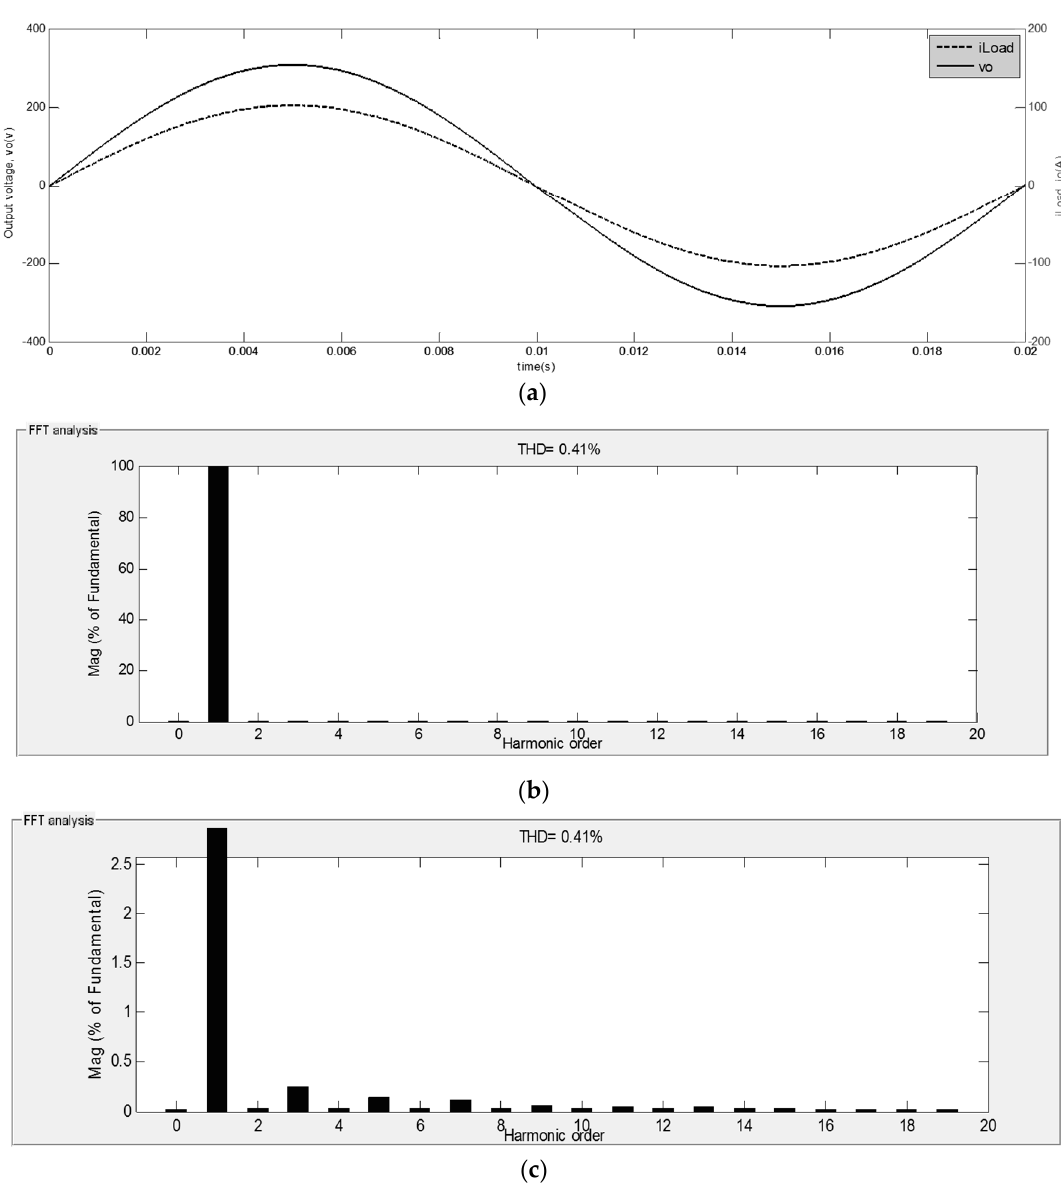
Figure 5. Simulation results for a resistive load: ( a ) output voltage and load current waveforms for a resistive load; ( b ) the spectrum of the output voltage for a resistive load; and ( c ) the spectrum of the output voltage for a resistive load.